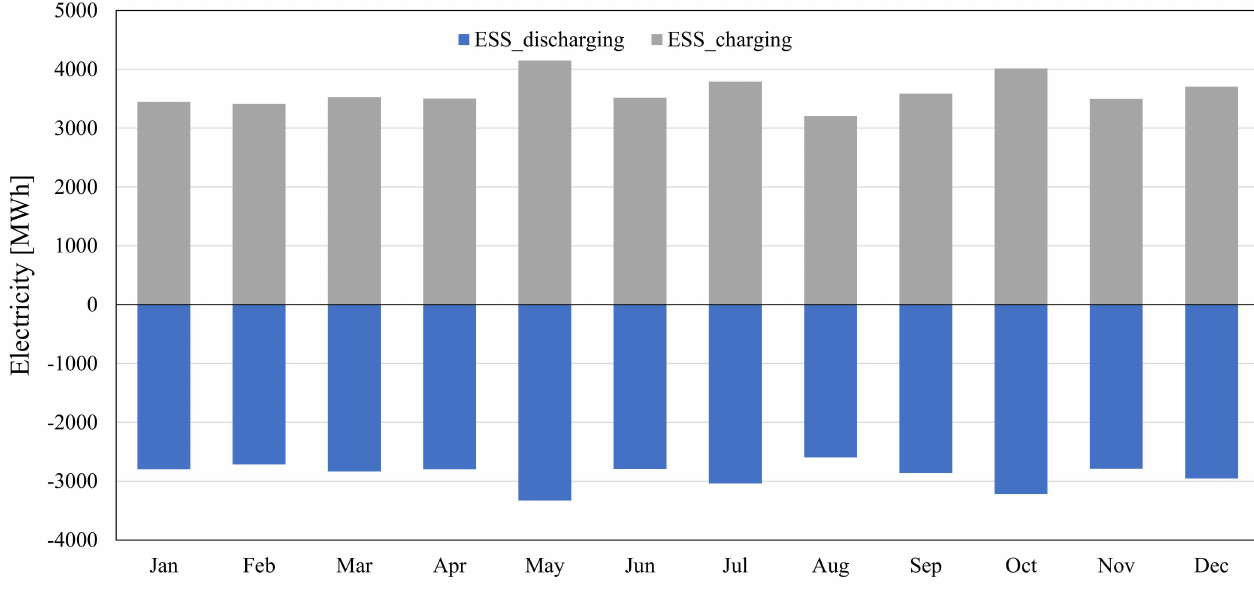
Figure 8. Monthly operating profile of